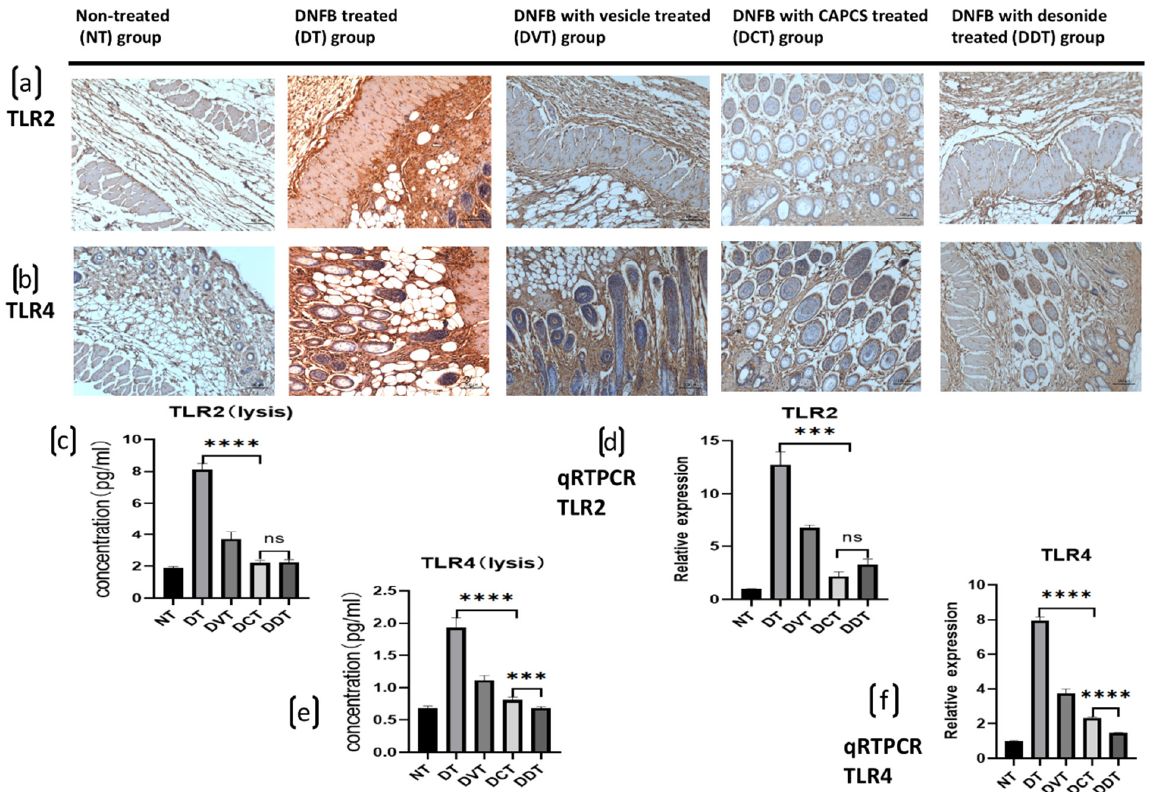
Figure 5. TLR2 and TLR4 immunohistochemical staining, protein expression in dorsal skin lesions, and qRT-PCR in each group of BALB/c mice. ( a ) Immunohistochemical staining of TLR2 in dorsal AD-like skin lesion (200×). ( b ) Immunohistochemical staining of TLR4 in dorsal AD-like skin lesion. ( c , d ) Expression of TLR2 was significantly increased in the DT, DVT, DCT, and DDT groups, in comparison to the NT group, and the expression was significantly decreased in the DCT and DDT groups, in comparison to the DT and DVT groups in skin lesions. ( e , f ) Expression of TLR4 was significantly increased in the DT, DVT, DCT, and DDT groups, in comparison to the NT group, and the expression was significantly decreased in the DCT and DDT groups, in comparison to the DT and DVT groups in skin lesions (data are presented as the mean ± S.E.M; ns: no significance, *** p < 0.001, and **** p < 0.0001).